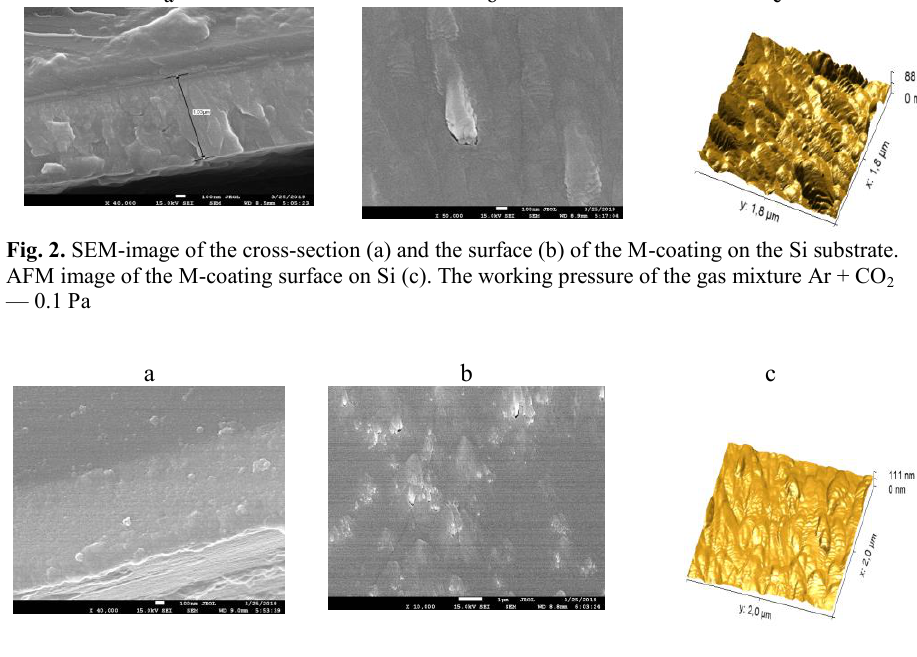
Fig. 3. SEM-image of the cross-section (a) and the surface (b) of the M-coating on the Si substrate. AFM image of the M-coating surface on Si (c). The working pressure of the gas mixture Xe + CO 2 — 0.075-0.08 Pa